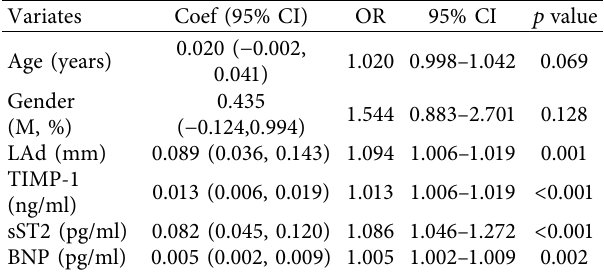
Table 4: Multivariable predictors of atrial fbrillation progression among patients in the